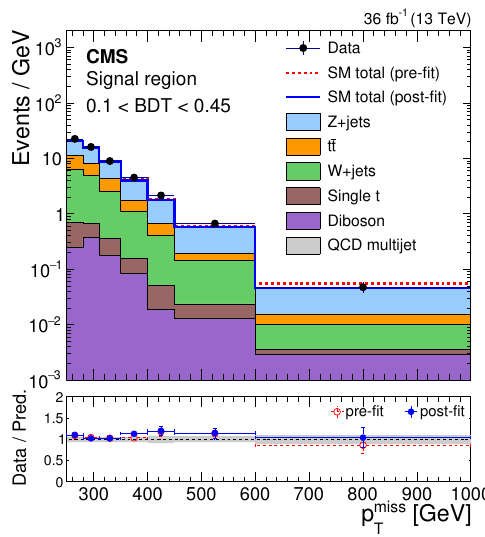
Figure 16 . Distribution of p miss from SM backgrounds and data in the loose category of the signal T region after (cid:12)tting the control regions only. Each bin shows the event yields divided by the width of the bin. The stacked histograms show the individual SM background distributions after the (cid:12)t is performed. The lower panel of the (cid:12)gure shows the ratio of data to (cid:12)tted prediction. The gray band on the ratio indicates the one standard deviation uncertainty on the prediction after propagating all the systematic uncertainties and their correlations in the (cid:12)t.